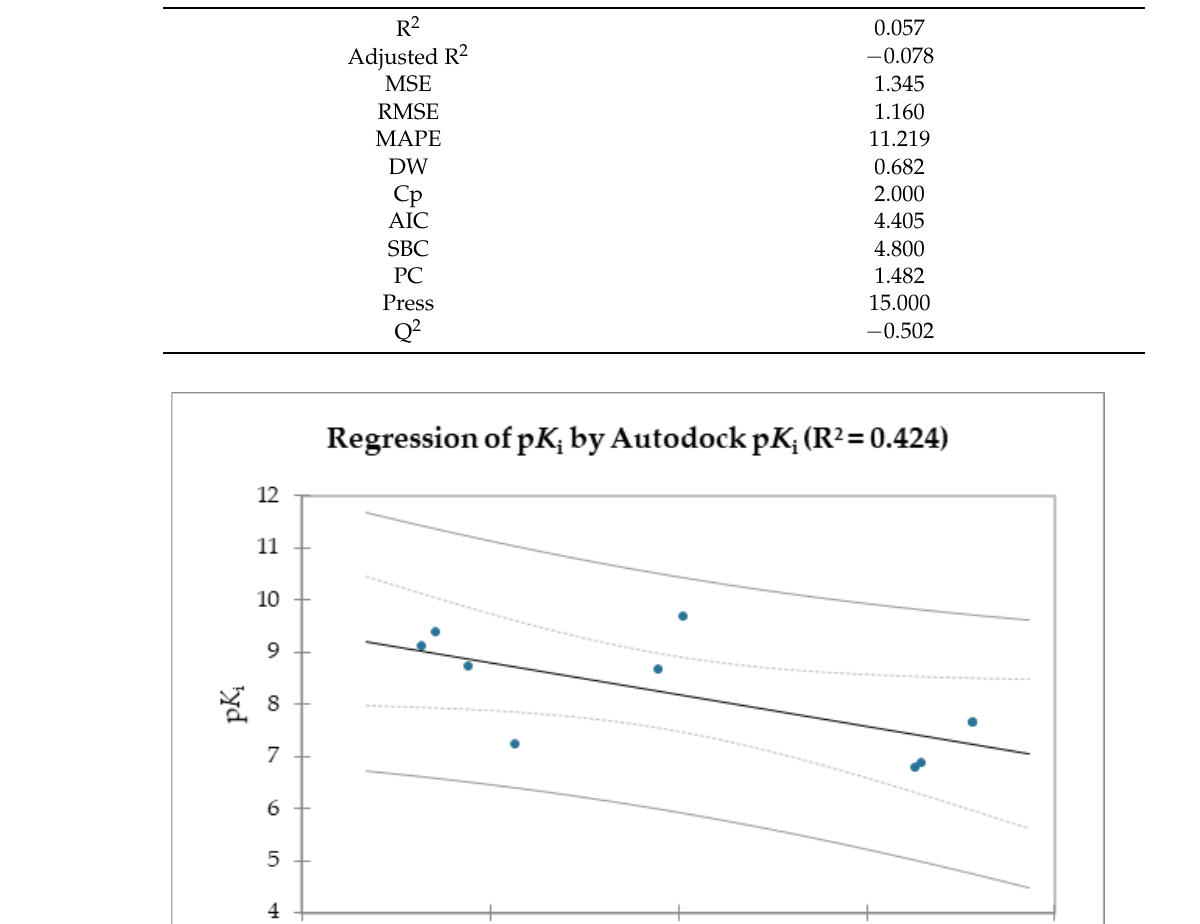
Table 2. FABP4 experimental K i and free energy of binding; Δ G bind calculated with Autodock, Vina, MM/PBSA, and MM/GBSA (kcal/mol). Table 4. Goodness of fit statistics (Autodock p K i ).